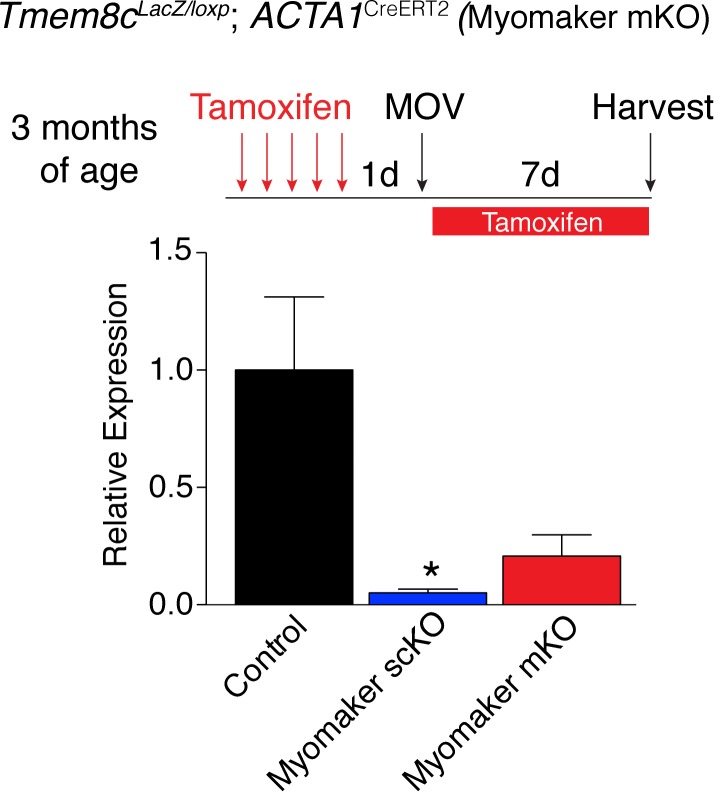
Myomaker expression is reduced in myomaker mKO mice when tamoxifen is present concominant with satellite cell activation suggesting ACTA1CreERT2 is active in myoblasts prior to fusion (n = 3–4 mice).These data indicate the ACTA1CreERT2 transgene is functional. Data are represented as mean ± SEM, *p<0.05.